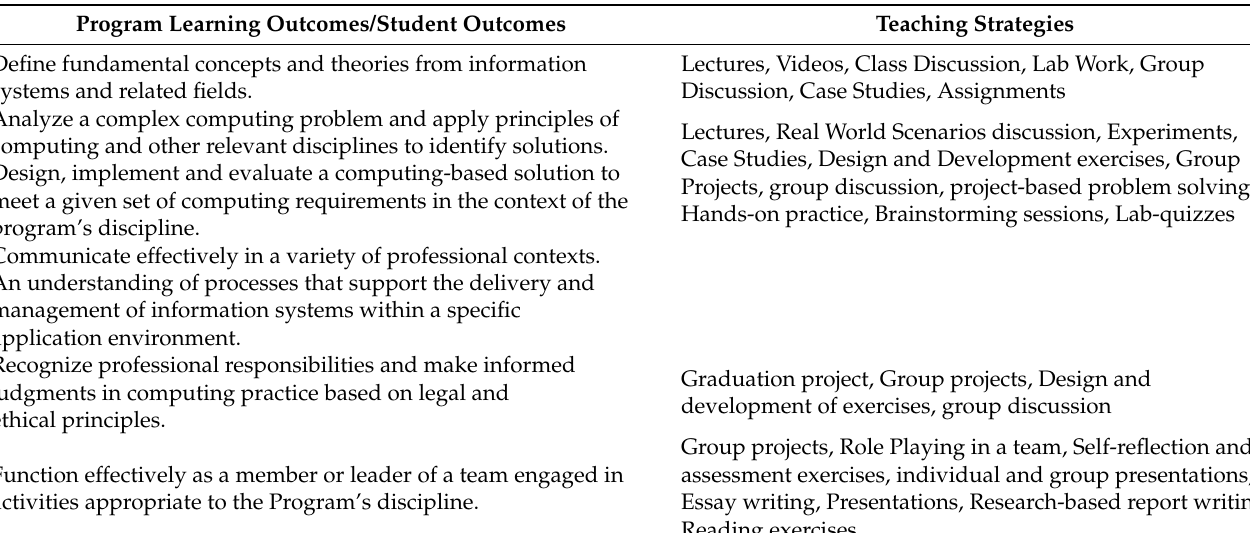
Table A1. Learning Outcome and Teaching Strategies